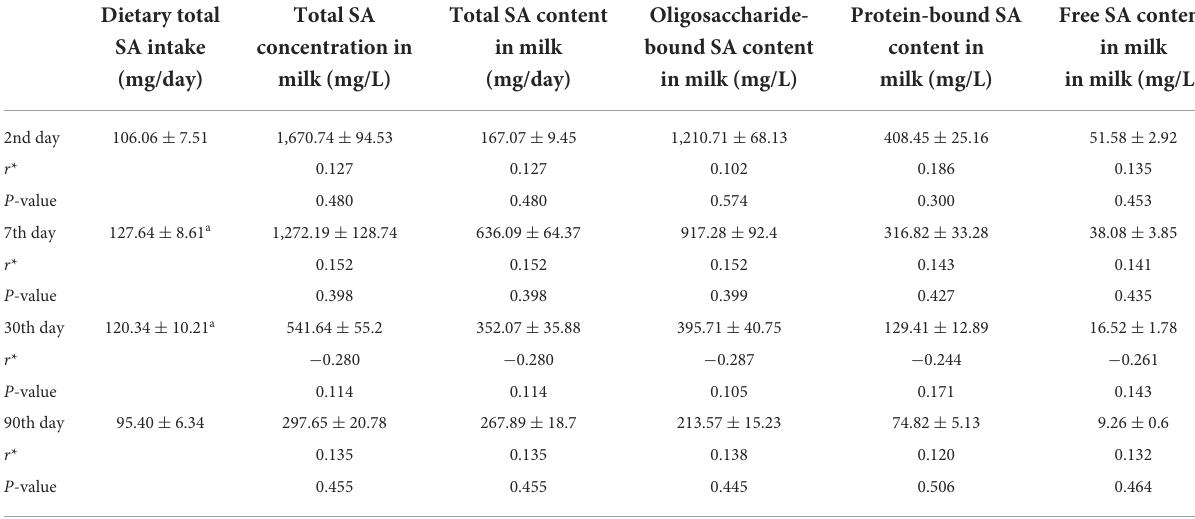
TABLE 2 The concentration of sialic acid in human milk at 4-time points during lactation (mg/L, mean ± SE, n = 33). Dietary total Total SA Total SA content Oligosaccharide- Protein-bound SA Free SA content SA intake concentration in in milk bound SA content content in in milk (mg/day) milk (mg/L) (mg/day) in milk (mg/L) milk (mg/L) in milk